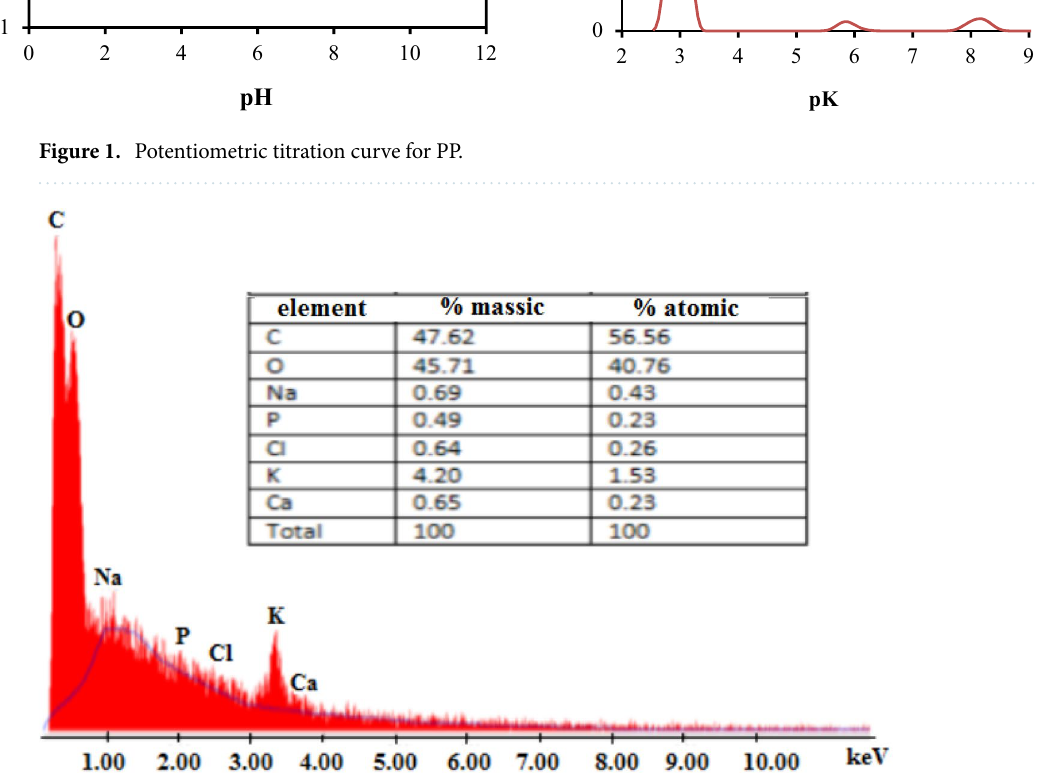
Figure 2. EDX spectrum and elemental analysis of potato powder